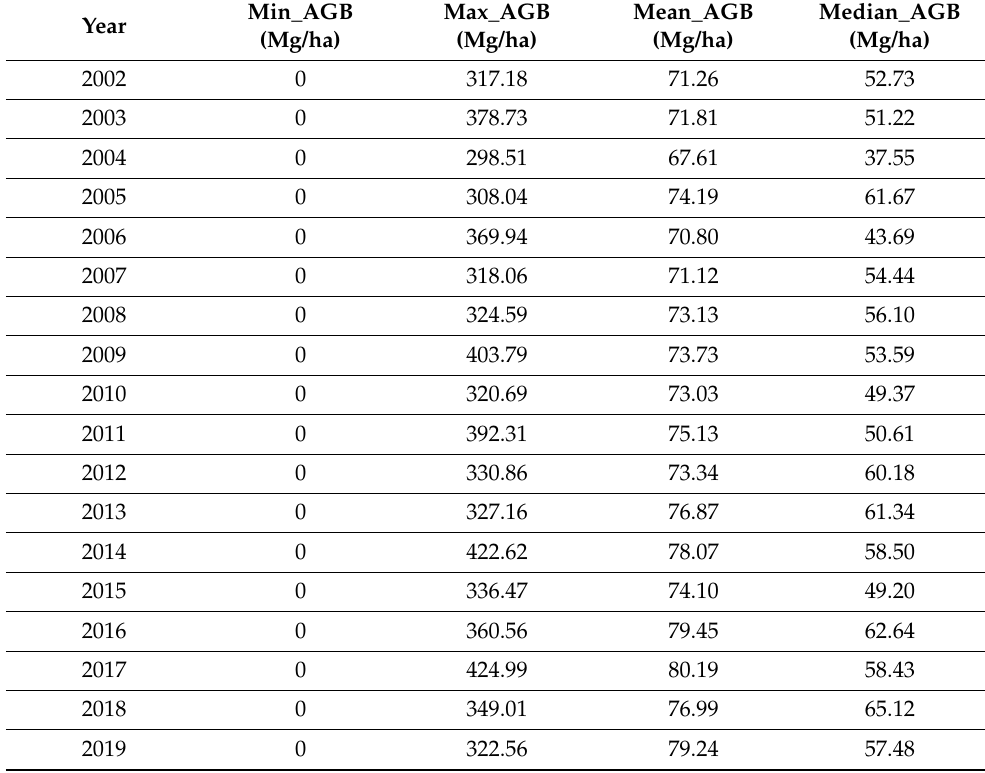
Table 1. The statistical characteristics of AGB values of FIA